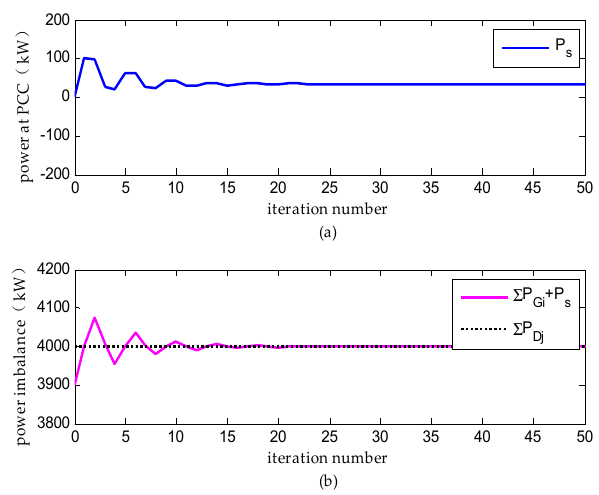
Figure 11. The simulation of power balance in Scenario D . ( a ) Power at PCC; and ( b ) The variation of power imbalance.